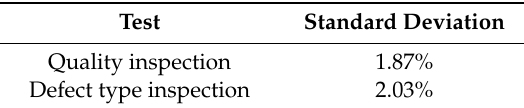
Table 5. Standard deviation of the